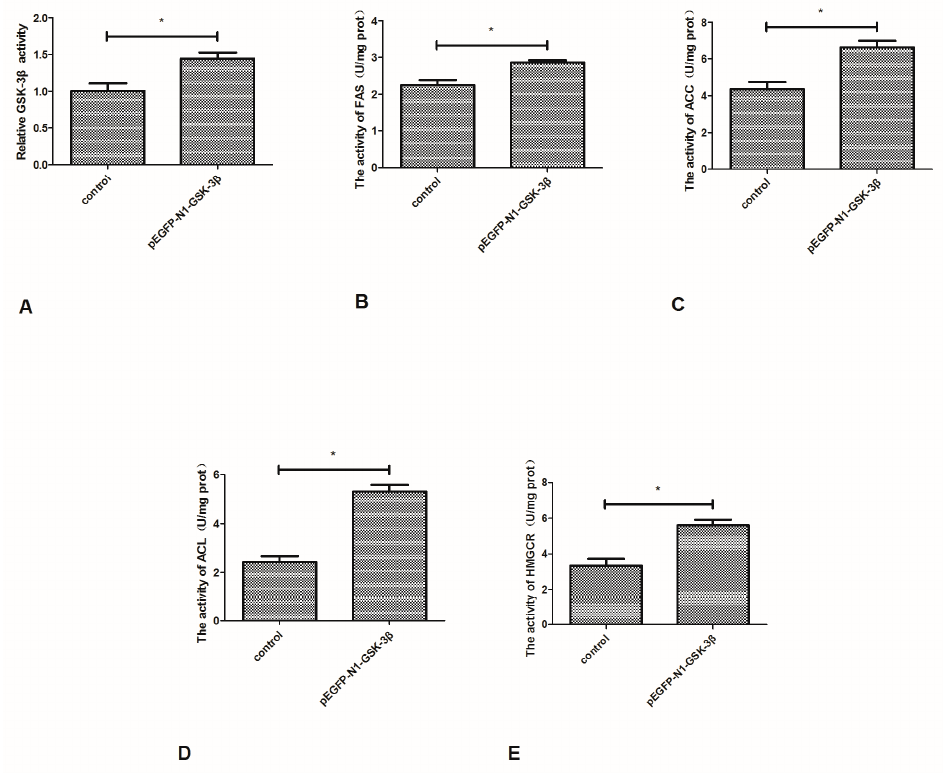
Figure 4. Effect of the pEGFP-N1-GSK-3 β vector on the activity of GSK-3 β , FAS, ACC, ACL, and HMGCR in the muscle of zebrafish. ( A ) GSK-3 β ; ( B ) FAS; ( C ) ACC; ( D ) ACL; ( E ) HMGCR. Values are expressed as means ± s.e.m. ( n = 6). Statistically significant differences are denoted by asterisk ( p < 0.05).